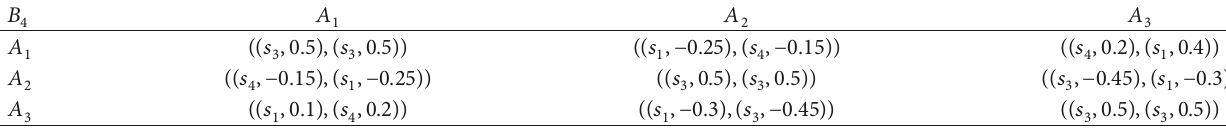
Table 6: I2TLPR of alternatives concerning the criterion 𝐶 4 .